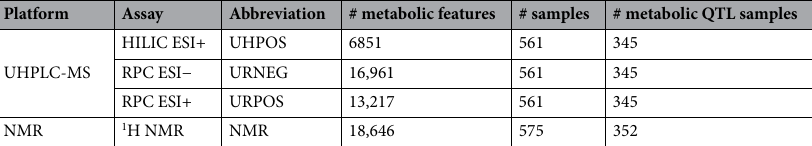
Table 2. Summary of samples and metabolic features available for the analysis. Details of used metabolomic platforms and assays are available in “Methods” section. Number of metabolic QTL samples—genetic and metabolic data